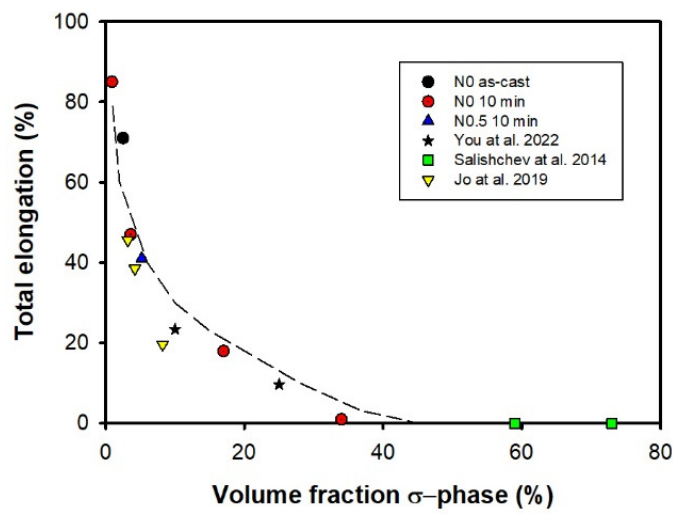
Figure 11. Dependence of tensile ductility on the volume fraction of the σ -phase, data from [22,25,27]. The impact toughness of the program alloys (Table 6) was also often low. The correla- tion between the impact toughness and tensile ductility of the alloys (Figure 12) suggests that low toughness is associated with the brittleness of the alloys under tension, the reasons of which were described in detail in the previous paragraphs. To ensure adequate tough- ness ( ≥ 25 kJ/m 2 ), tensile elongation of ≥ 20% is required (see the area separated by the dashed red lines in Figure 12). However, there was no correlation between the toughness values and the tensile properties for the alloys with adequate toughness. Future work is required to find the links between the microstructure, tensile properties, and toughness of the alloy, which is beyond the scope of the current paper.